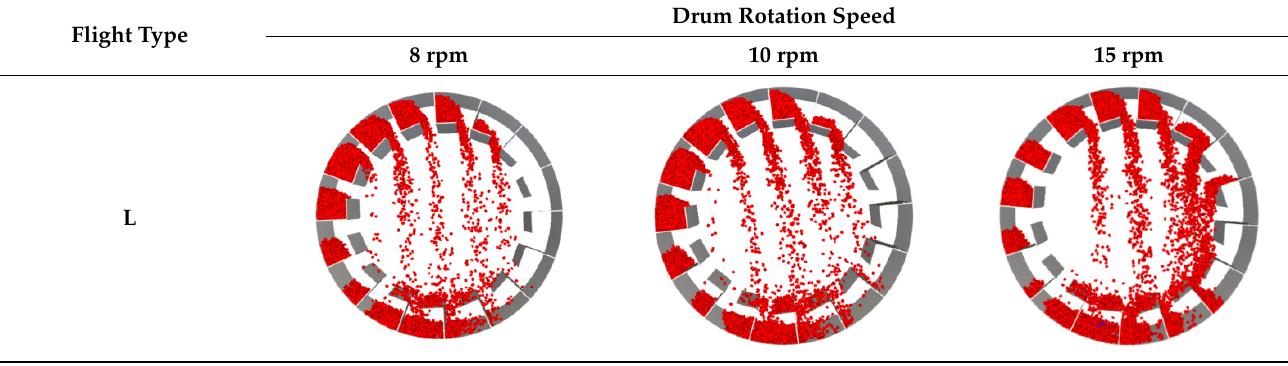
Table 5. The image of the particle dispersion mode for different flights shape and 10% drum filling